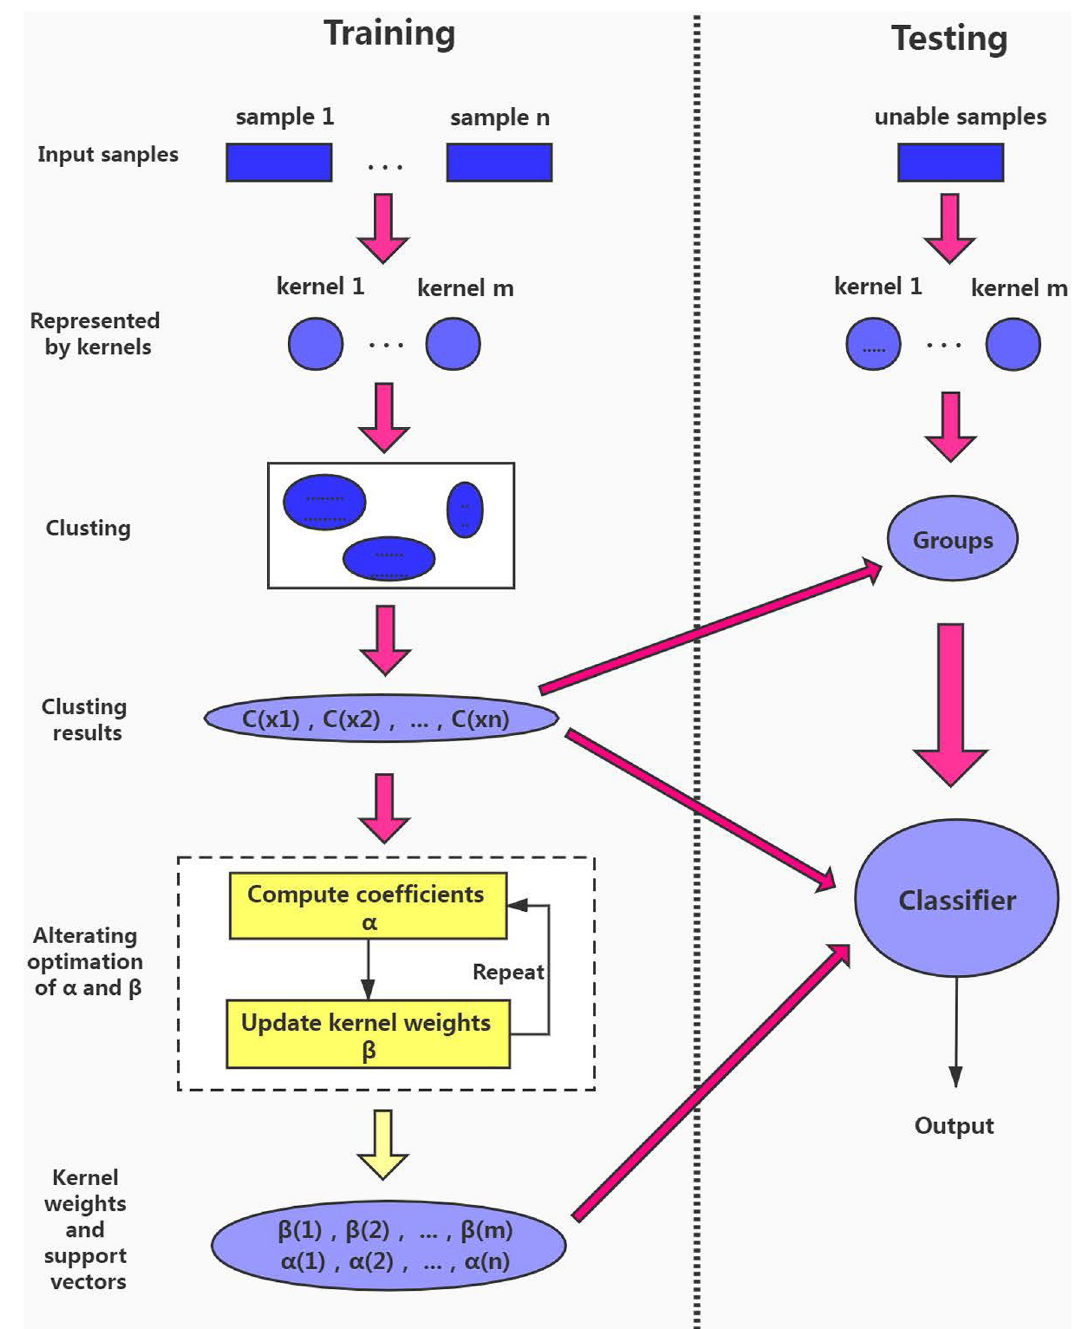
Fig 5. The training and testing process in